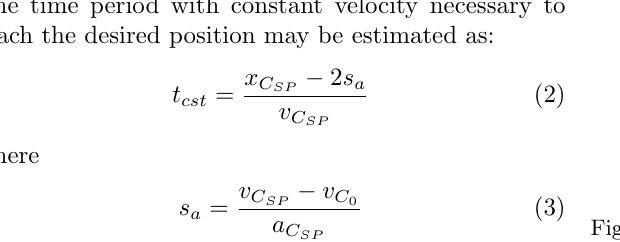
Figure 5: Main arm at max reach ( x R = 4 [ m ] and x MA 0 [ m ]).